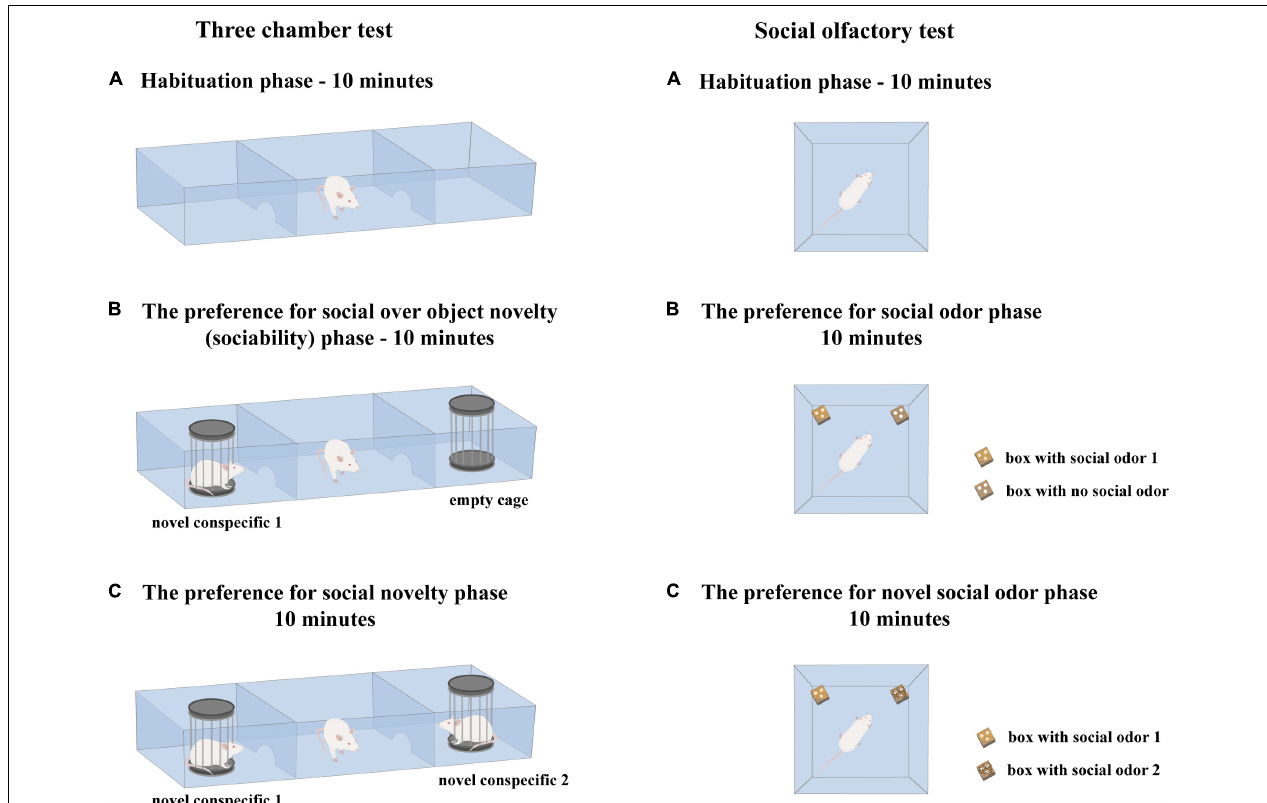
FIGURE 2 | Schematic presentation of experimental procedures related to the 3-chamber test and the social olfactory test. The schemes are given to visualize uniform handling procedures used in the 3-chamber test and the social olfactory